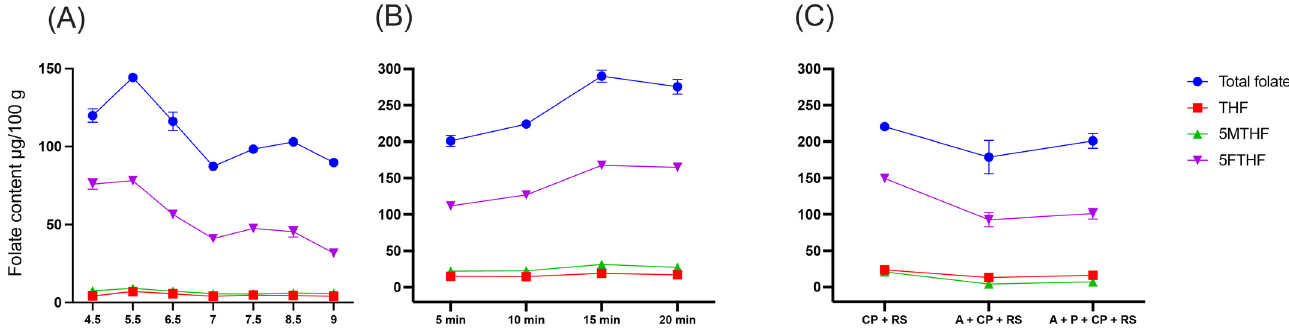
Figure 2. The total folate, THF, 5MTHF, and 5FTHF contents of soybean seeds under